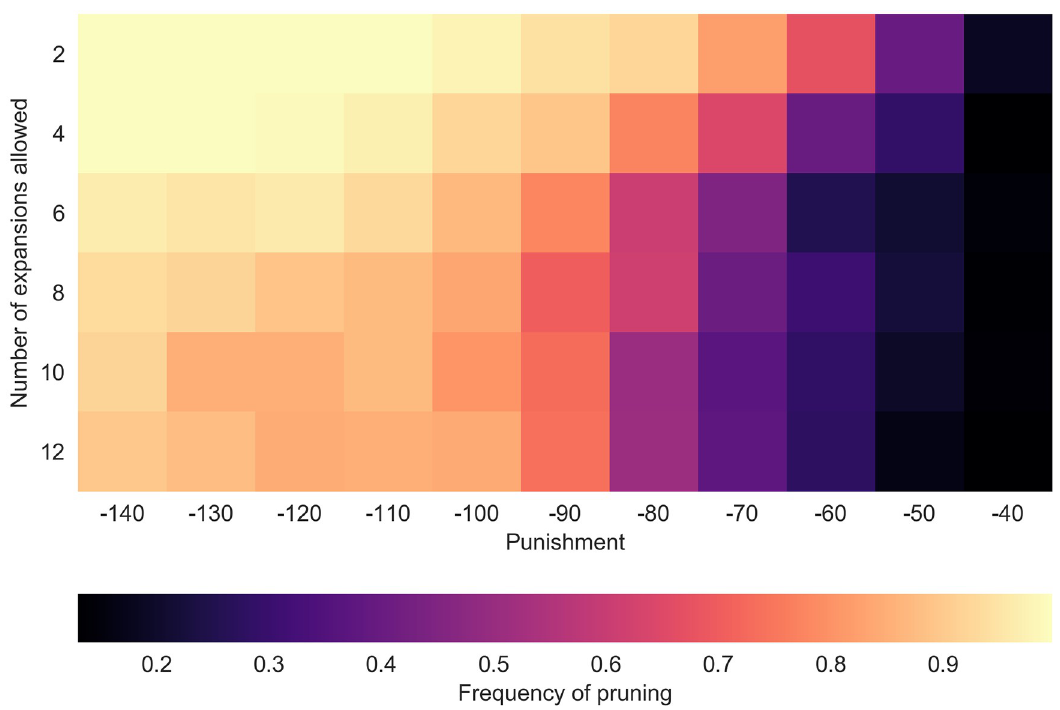
Fig 4. The frequency of pruning the branch with the large punishment. The black area on the right is the region where the agent does not prune (i.e., expands) the punishment branch. Each condition is averaged over 300 simulations.